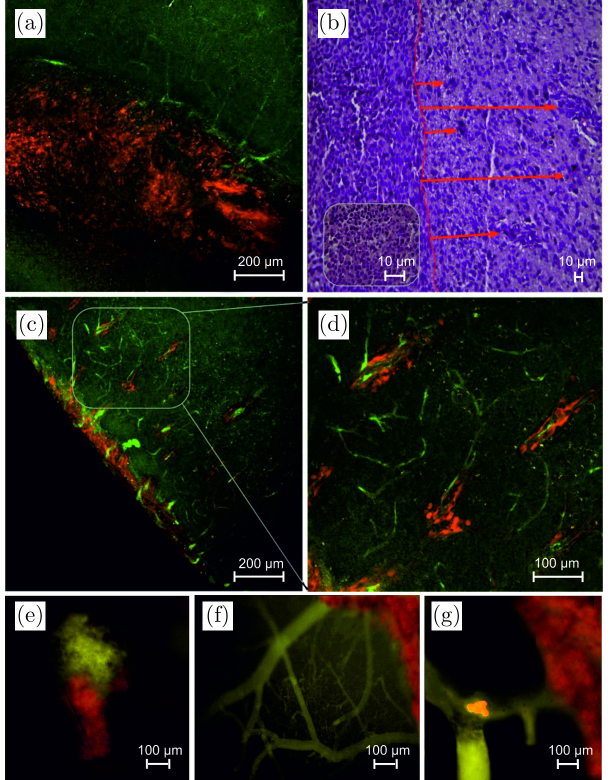
Fig. 1. The analysis of GCs migration and the BBB disrup- tion: (a) confocal imaging of °uorescent glioma (red color) 28 days after GCs implantation; green color-the cerebral vessels ¯lled FITC-dextran 70 kDa; (b) histological analysis of GCs migration (arrowed) from the main tumor mass in the normal brain tissues; ¯gure at high magni¯cation shows polymorphism of cancer cells; (c) GCs migration (circled) from initial tumor in the subcortical area; (d) the same area at high magni¯cation from (c), shows migration of GCs along the cerebral vessels; (e) °uorescence microscopy of signi¯cant FITC-dextran (green color) extravasation in the main tumor mass (red color); (f) the intact BBB is impermeable for FITC-dextran that is inside of the cerebral vessels within the border between tumor mass and the normal brain tissues; (g) °uorescence microscopy of GCs (red color) migration via the cerebral vessel ¯lled up by FITC- dextran. For confocal imaging, approximately 10 – 12 slices per animal ð n ¼ 10 Þ were imaged.